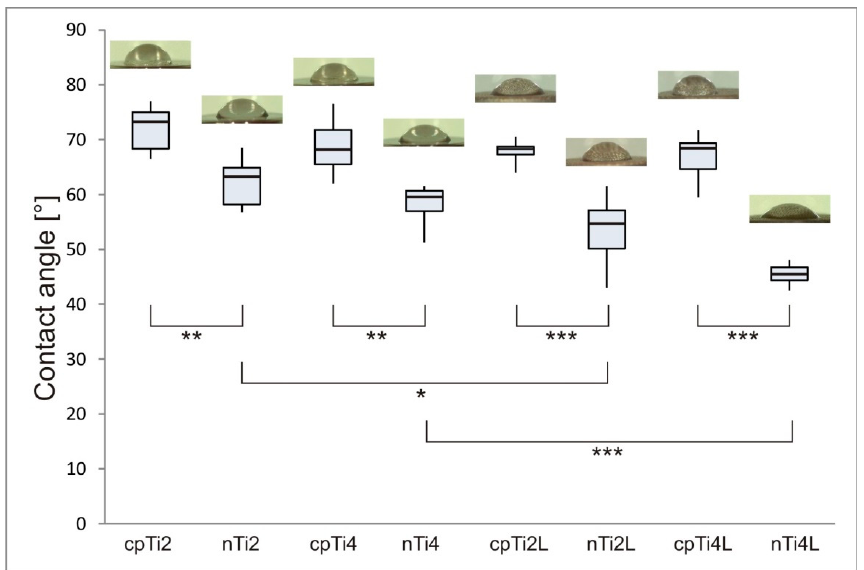
Figure 3. Water contact angle for different surfaces and water droplet morphologies (minimum, 1st quartile, median, 3rd quartile, maximum; *, **, *** denotes statistically significant differences of p < 0.05, p < 0.01 and p < 0.001, respectively).